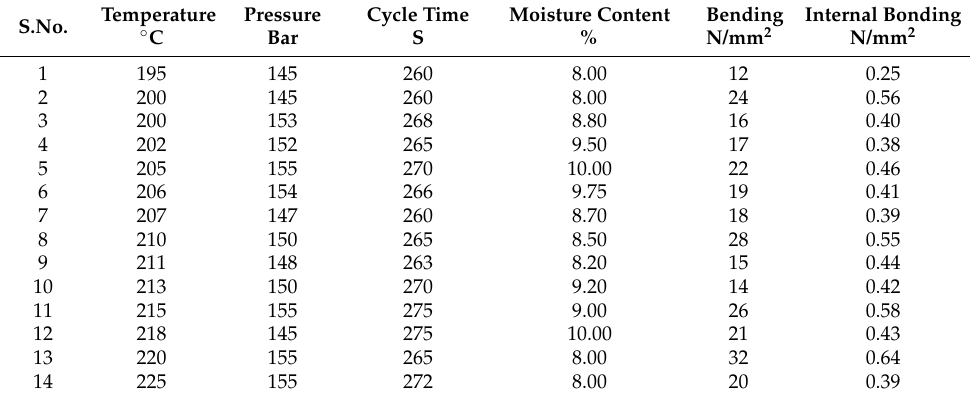
Table 2. Experimental data results.